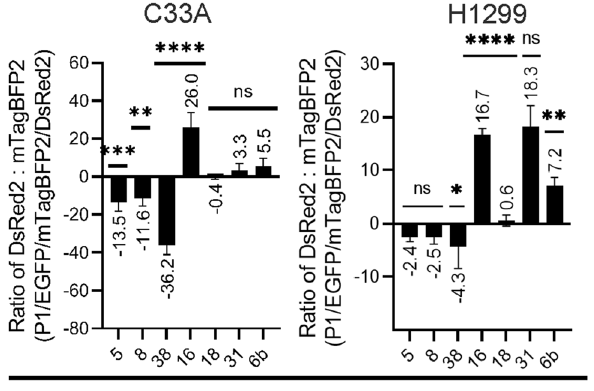
Figure 10. E6 activity on P-HES1 regulated genes. The ratio of mean fluorescence intensity (MFI) of DsRed2 and mTagBFP2 were calculated for each mTagBFP2-E6 based on the triple gating strategy as described in Fig. 6 and normalized to the control mTagBFP2, which has no effect on P-HES1 controlled DsRed2 expression (ratio set to zero). The more negative or positive the value the higher the repressing or activating activity of the respective E6. Data are derived from the average of three independent biological replicates with the mean value labelled above each bar. The error bars plotted are the standard deviation of the mean from the three independent biological replicates. P value were calculated using One-Way ANOVA with Fischer’s LSD test by comparing the mean of each activation and repression sample with the control activation sample where * = P ≤ 0.05, ** = P ≤ 0.01, *** = P ≤ 0.005, **** = P ≤ 0.0001, ns = P >